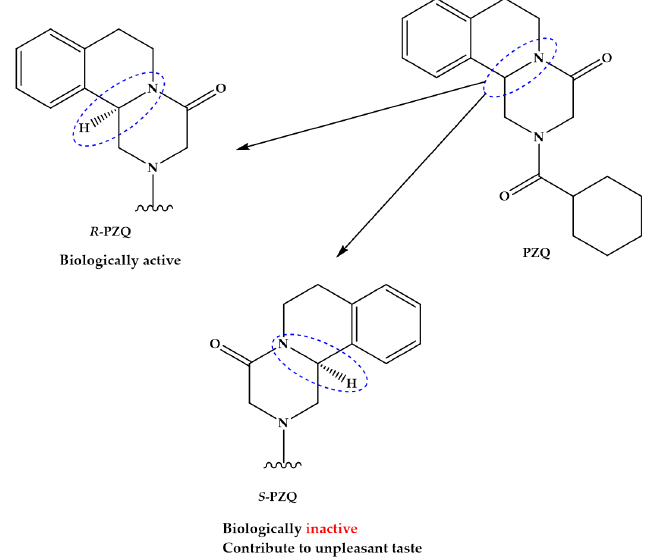
Figure 1. Chemical structures and characteristics of praziquantel and its enantiomers, R -PZQ and S -PZQ.